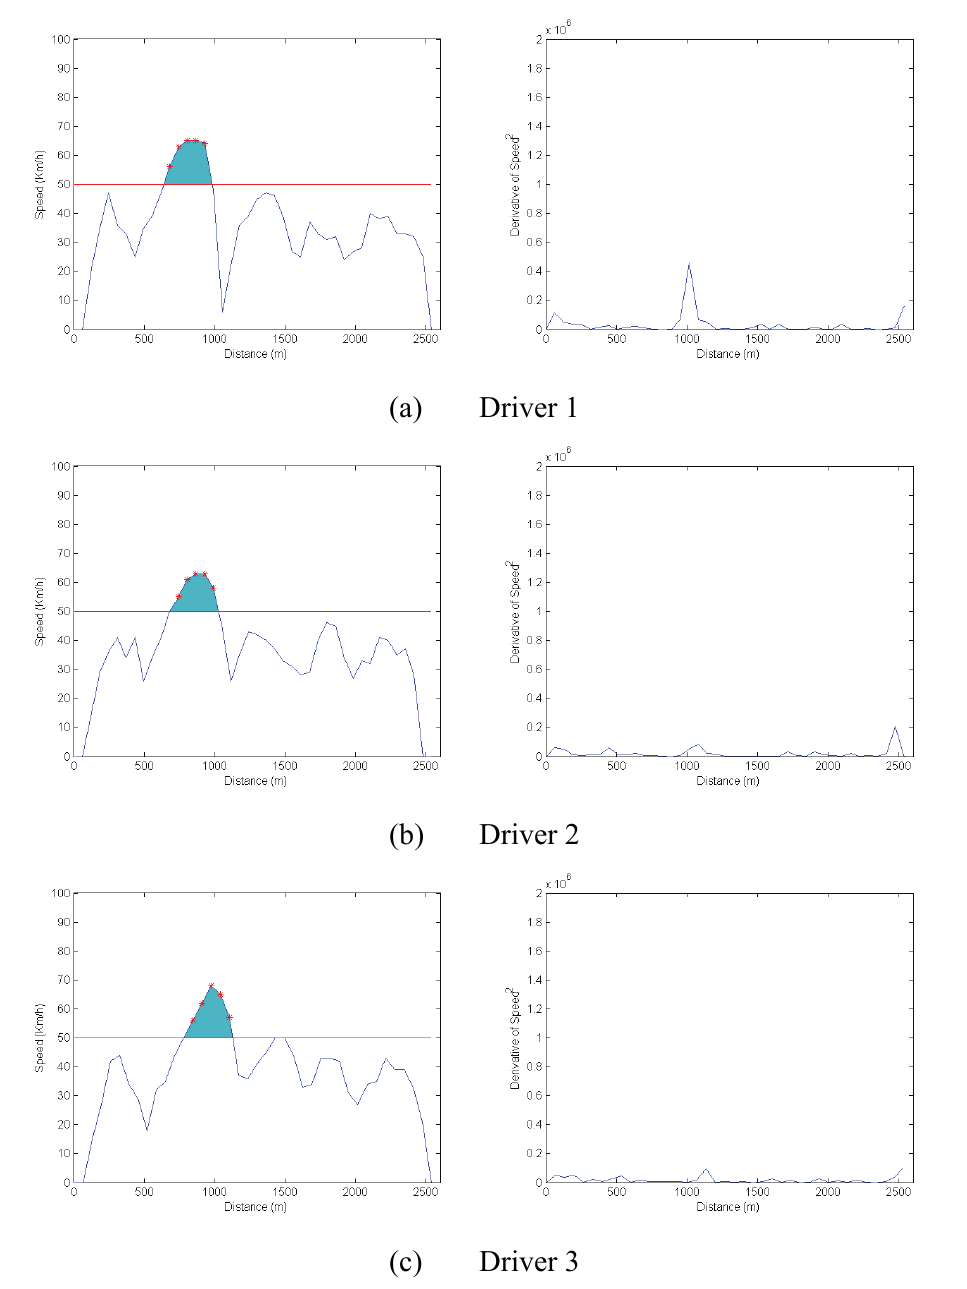
Figure 8. Results of non-aggressive